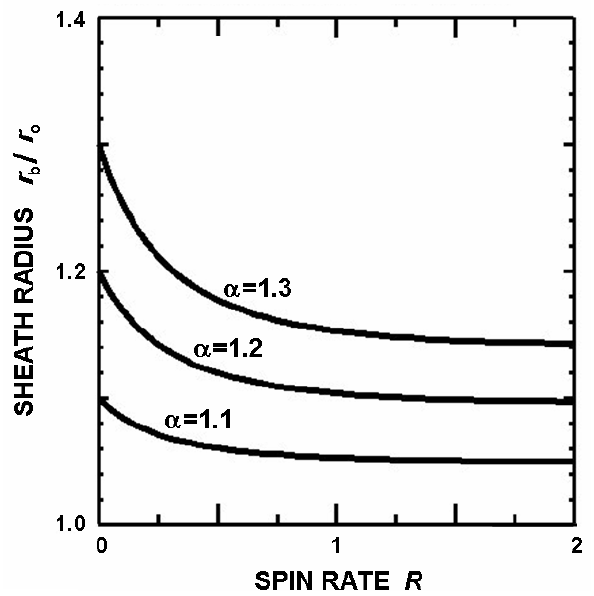
Fig. 6. The photoemission sheath radius, r b , at φ b , versus R .